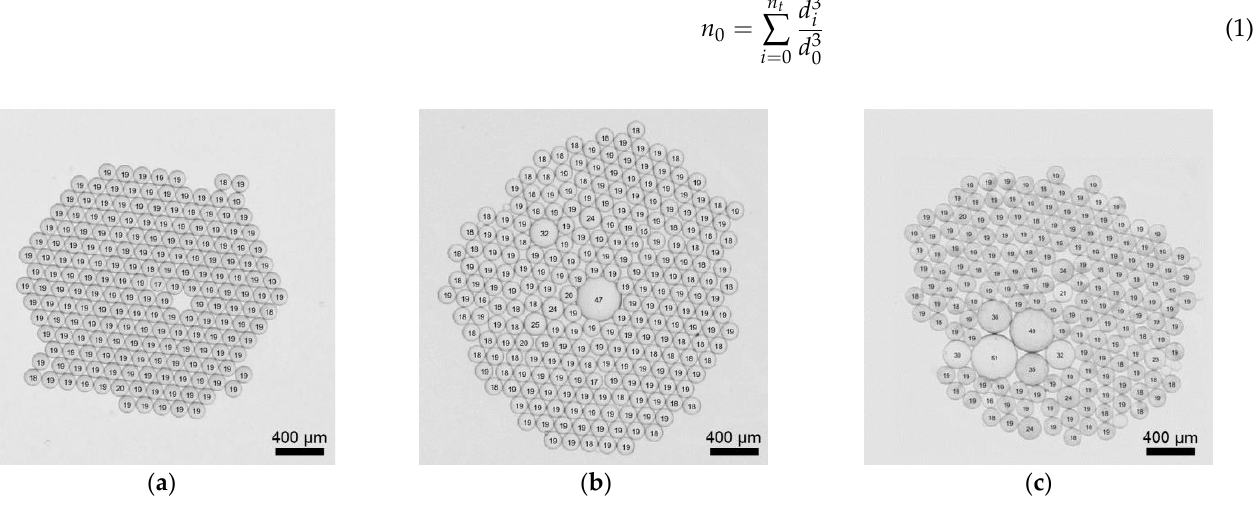
Figure 3. Exemplary micrographs of microfluidic double emulsions after different storage times. Each droplet is labelled with its diameter in pixels. ( a ) Emulsion droplets directly after production, the emulsion is monodispersed. ( b ) More stable formulation after three months. ( c ) More instable emulsion after storage of one day.